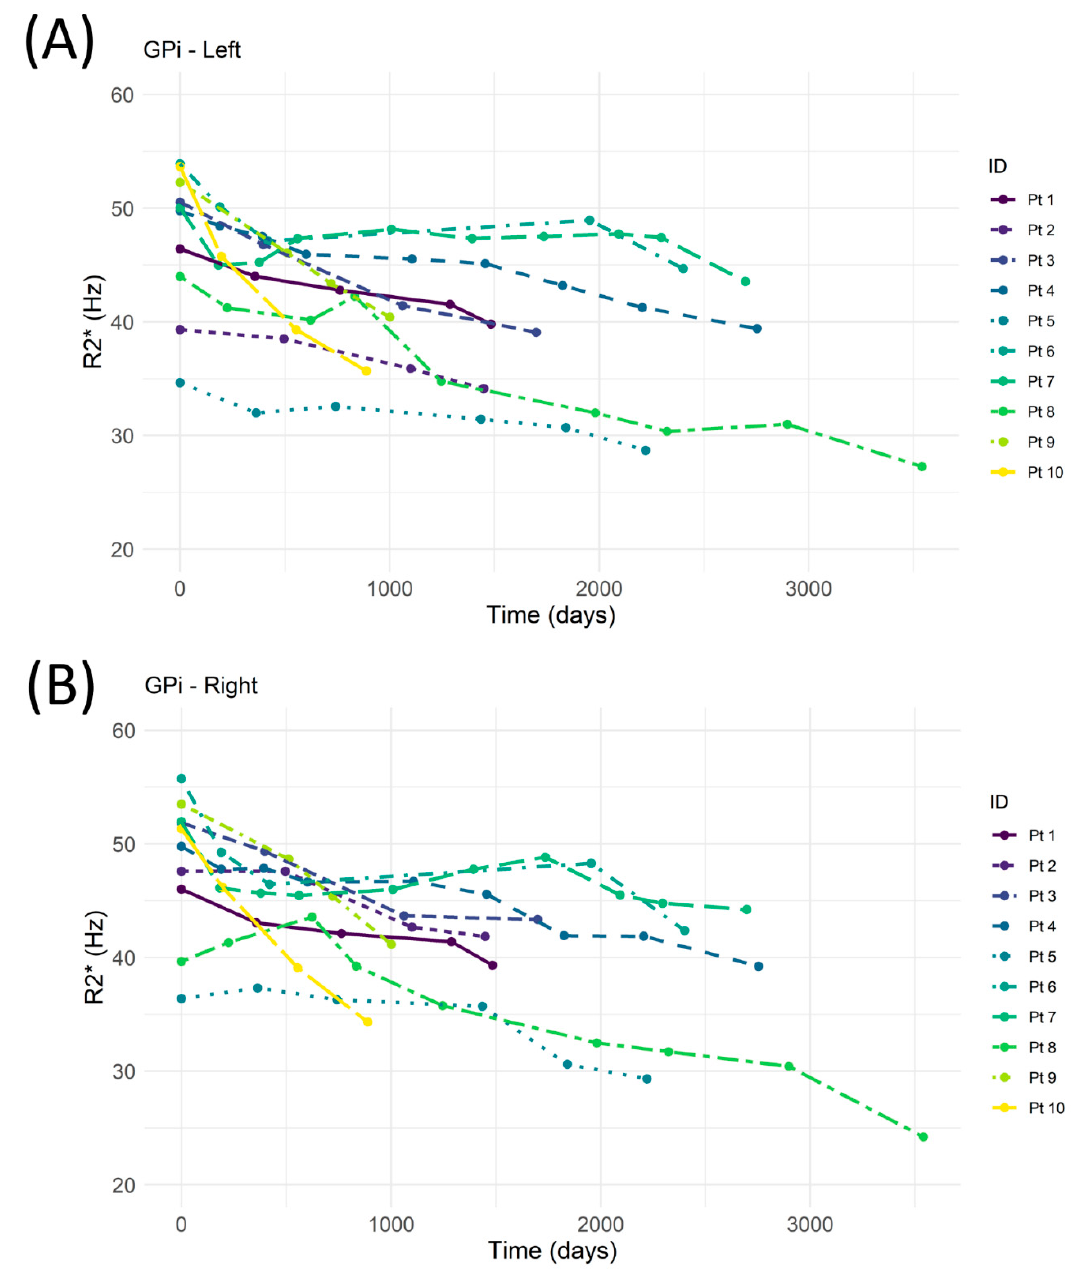
Figure 1. MRI-R2* evaluation of left ( A ) and right ( B ) globus pallidus internus (GPi) as a function of time. Pt (patient).